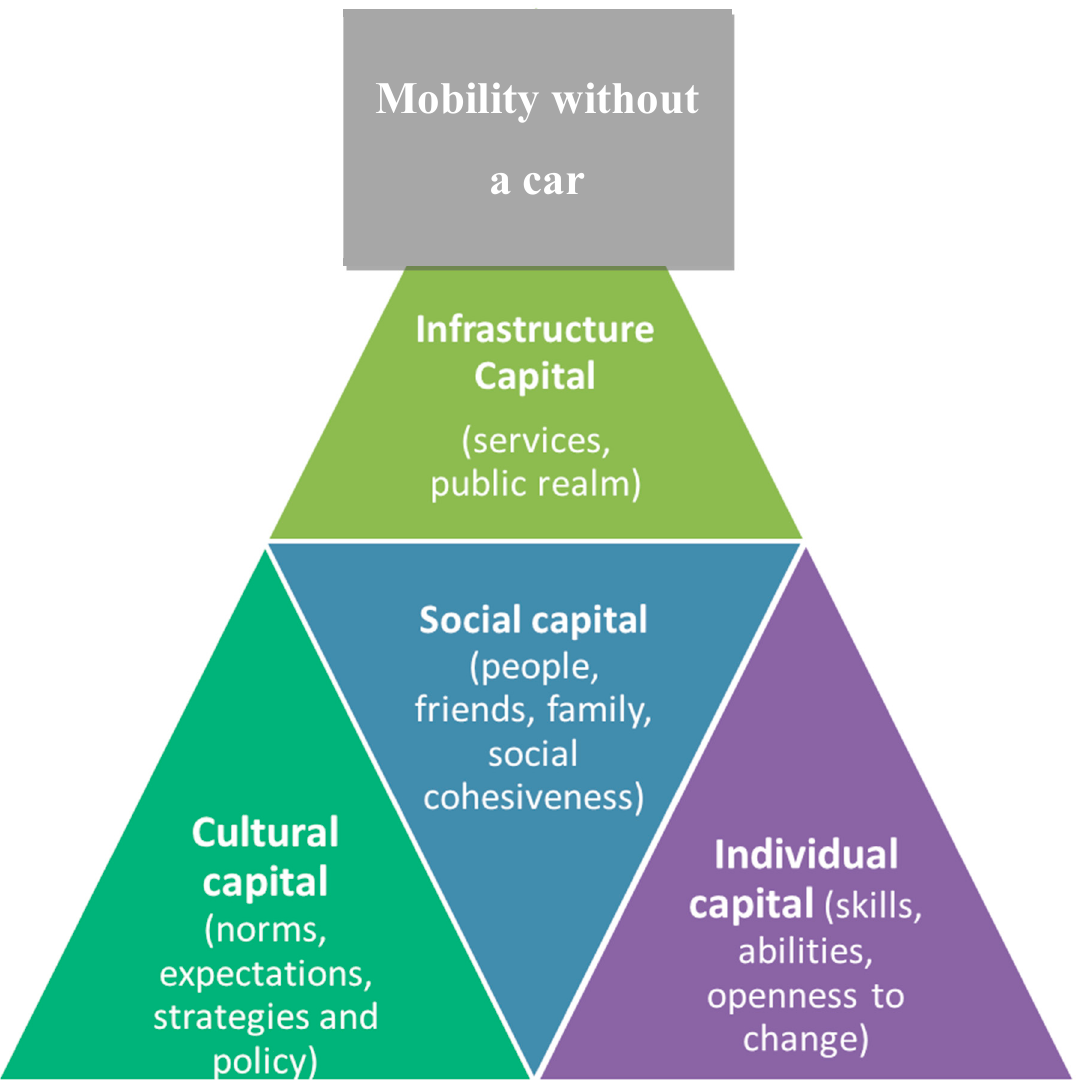
Figure 1. Theoretical model of mobility capital, showing the relationship of different capitals to enable mobility in later life for those not driving.